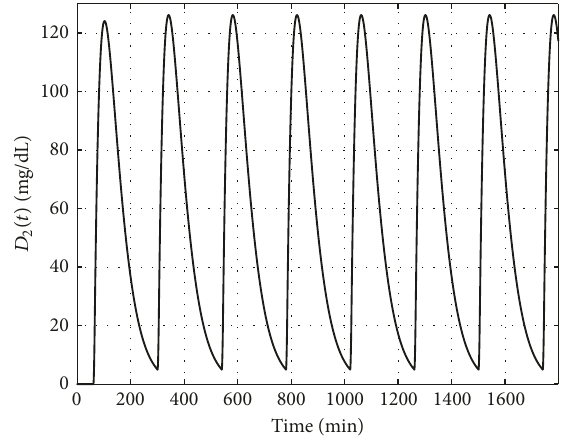
Figure 13: Variation of the second state of the glucose absorption subsystem.